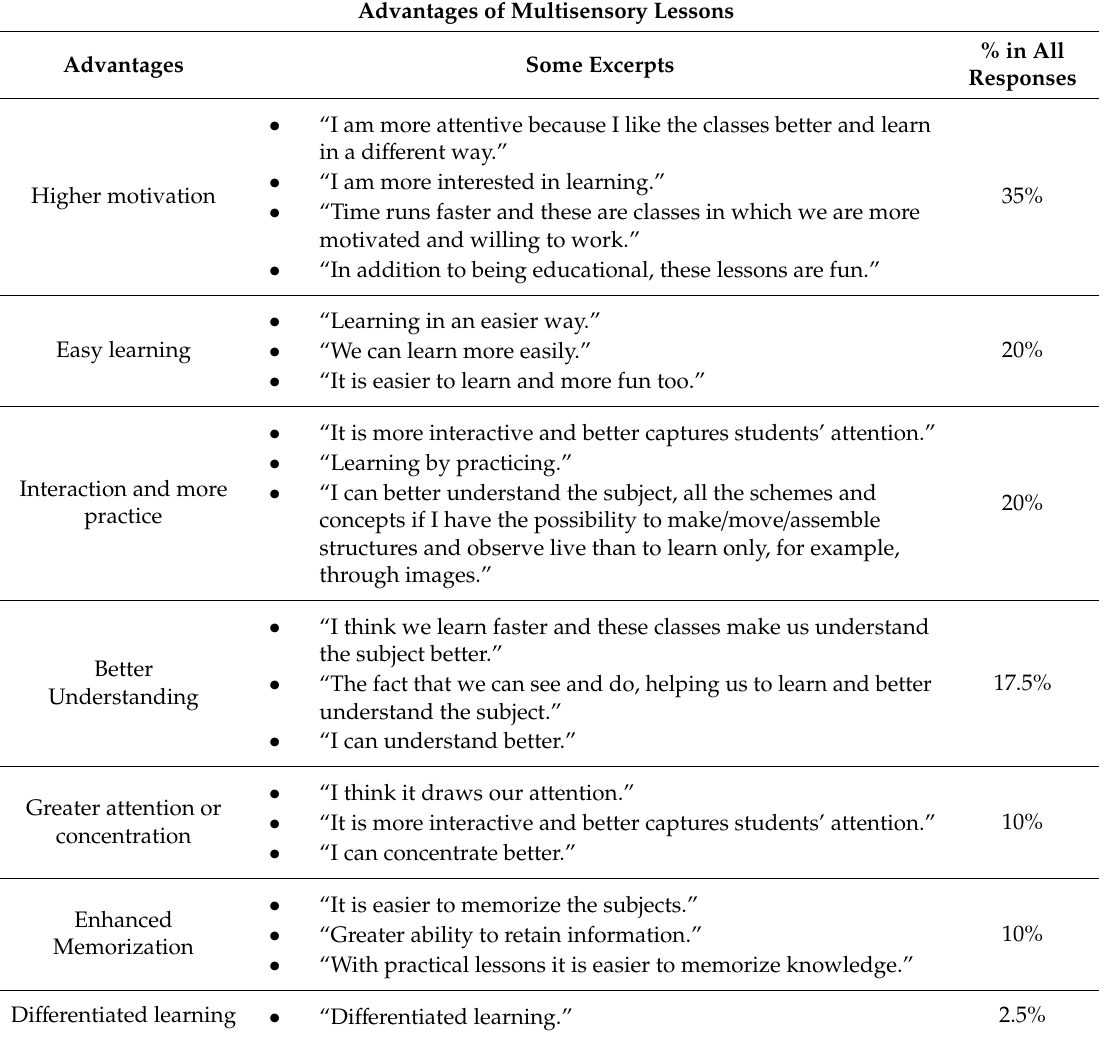
Table 5. Categorization of responses to the open-ended item “What is the main advantage of these lessons for you?” and frequency of appearance for each